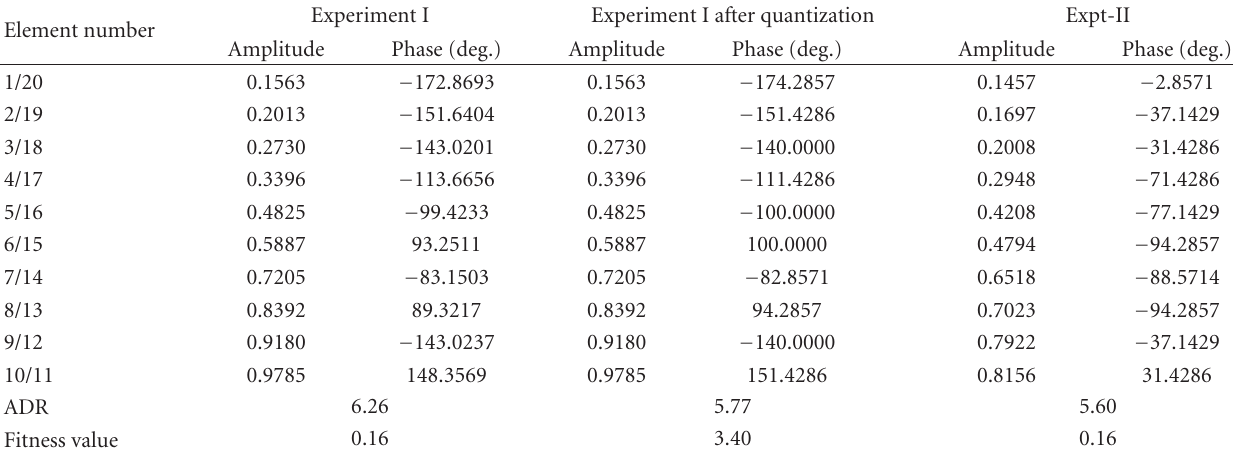
Table 2: Optimum results of experimental I and experiment II without ADR.